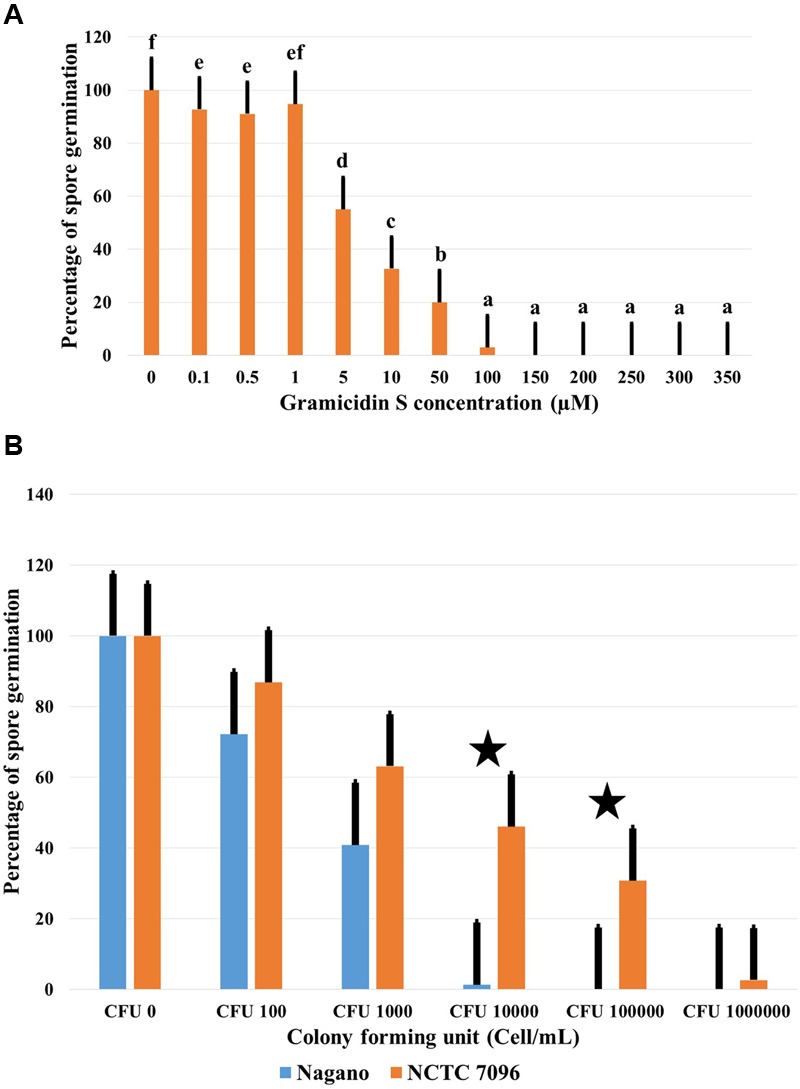
Effect of commercial GS and A. migulanus cells on B. cinerea conidiospore germination. (A) Effect of increasing GS concentrations on germination of B. cinerea DSM 4709 spores after 24 h exposure to the treatment. Vertical bars represent standard errors of the means of three independent replicates. Data presents mean ± standard error. Bars labeled with different letters are significantly different among the treatments at P < 0.05 using Tukey’s HSD test. In each bar group, bars labeled with the same letter are not significantly different from each other according to Tukey’s HSD at p < 0.05. (B) Reduction of B. cinerea DSM 4709 spore germination (%) caused by washed cells of A. migulanus () Nagano or () NCTC 7096. Bars labeled with asterisk are significantly different among the treatments at P < 0.05 using ANOVA analysis.